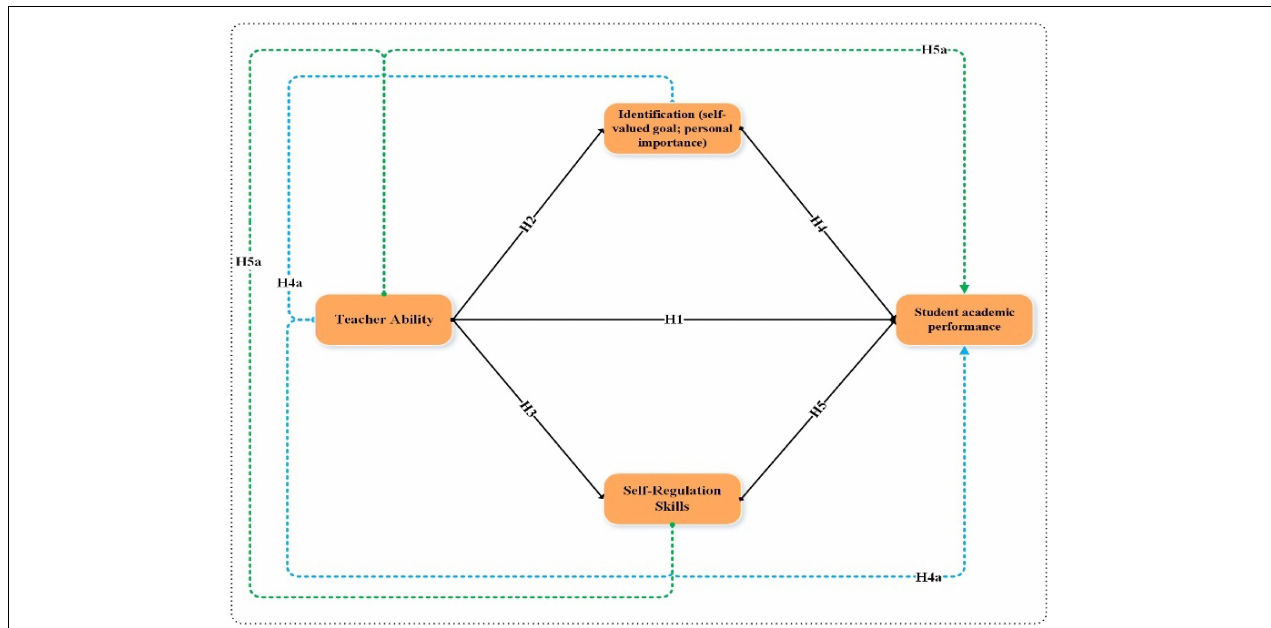
FIGURE 1 | Study conceptual